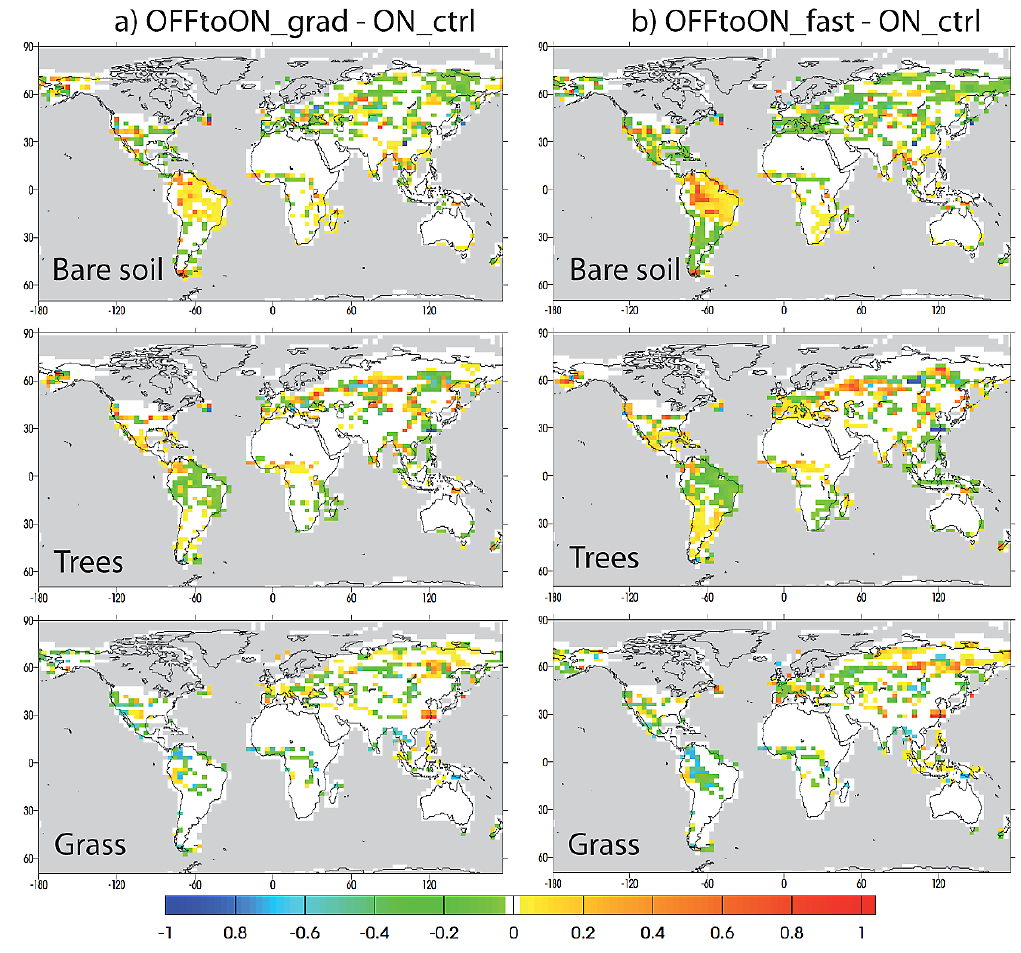
Fig. 4. Differences in the fractions of bare soil, trees and grass simulated by ORCHIDEE at the end of (a) OFFtoON grad and (b) OFFtoON fast compared to ON ctrl. OFFtoON grad: average over the last 30yr of the run. OFFtoON fast: average over the last 20yr of the run. ON ctrl: average over 500yr of